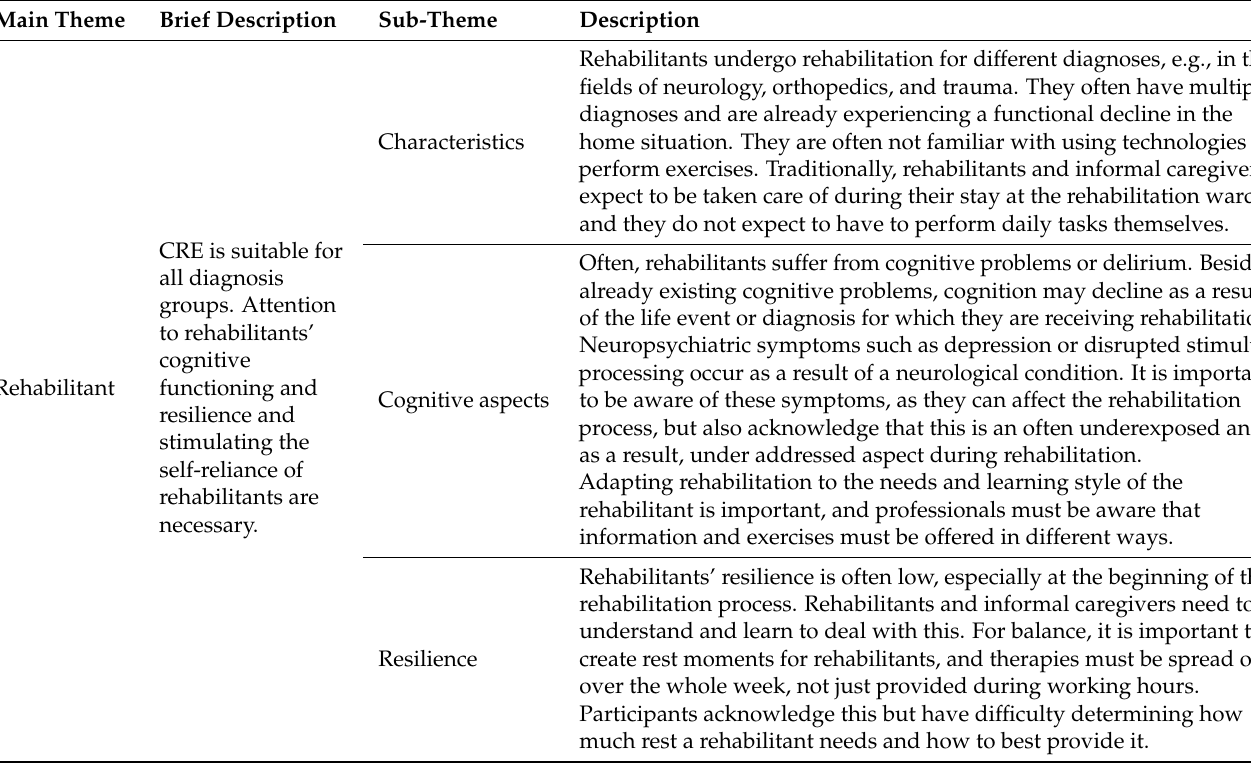
Table 2. Themes involving rehabilitation